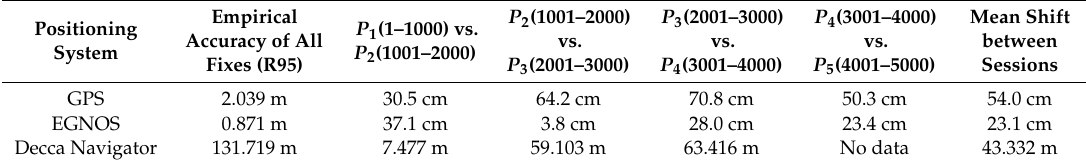
Table 4. Position coordinates shifts between sessions for three navigation positioning systems: GPS, EGNOS and Decca